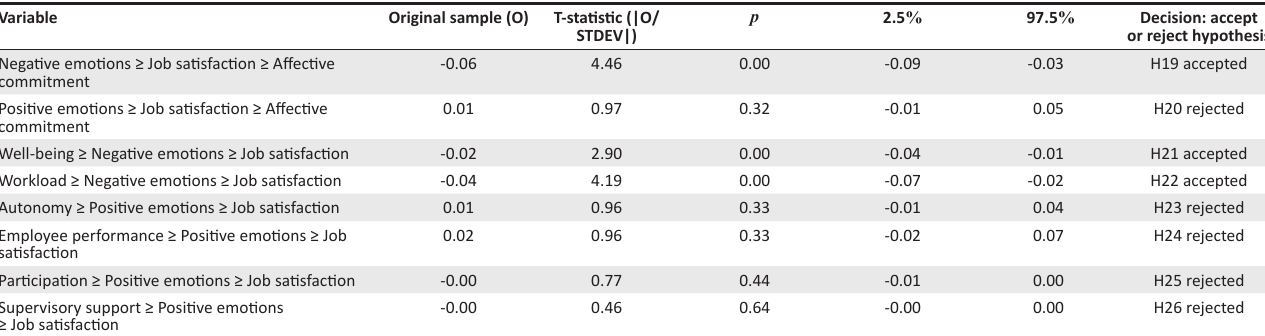
TABLE 6: Indirect effects.